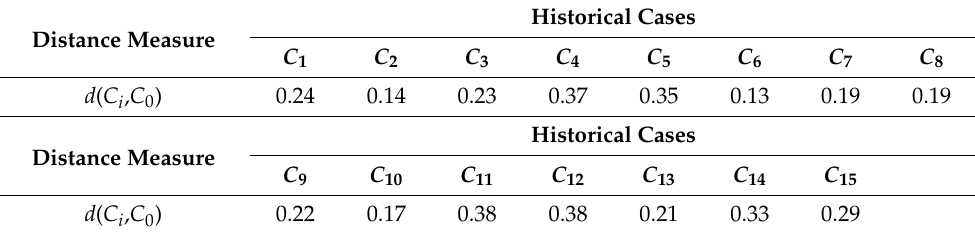
Table 8. Hybrid distance measure Dis ( C i , C 0 ) between historical enforcement cases C i and target enforcement case C 0